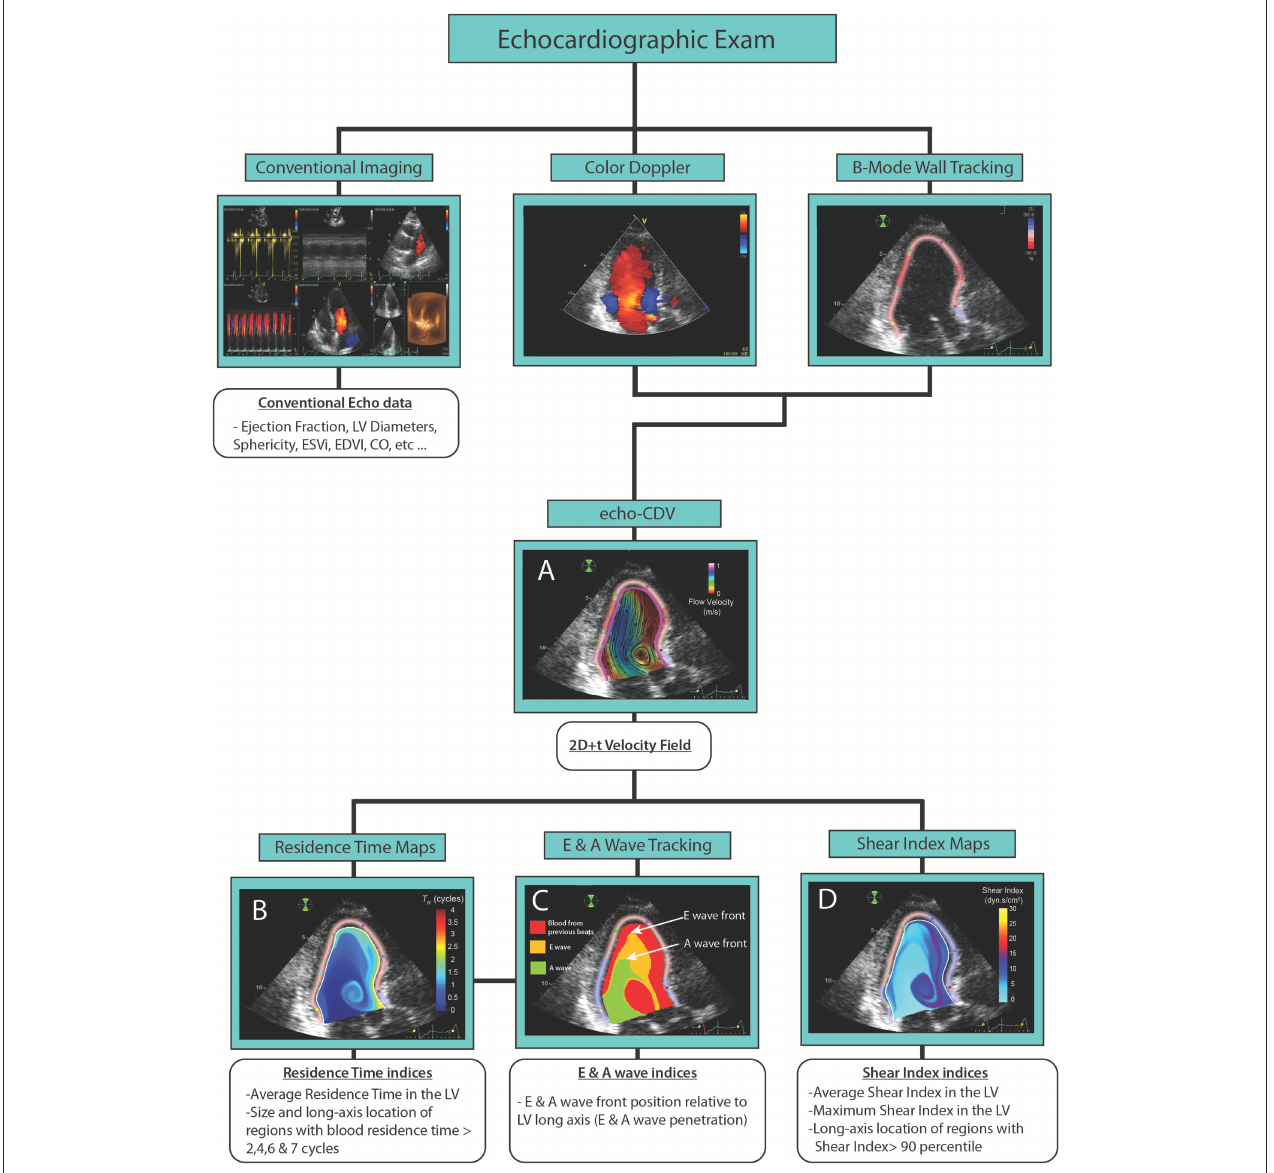
FIGURE 1 | Methods of image acquisition and processing. (A) Echo CDV velocity maps. (B) Residence Time maps. (C) E & A waves tracking maps. (D) Shear index maps.